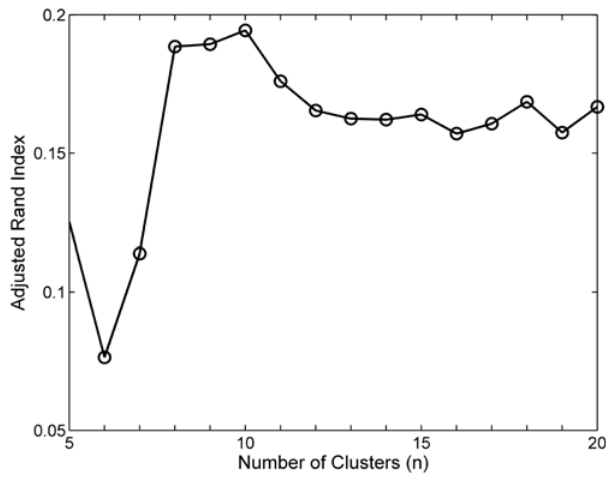
Figure 14. Adjusted Rand Index comparing similarity of SFN themes and NCuts-based partitioning versus number of